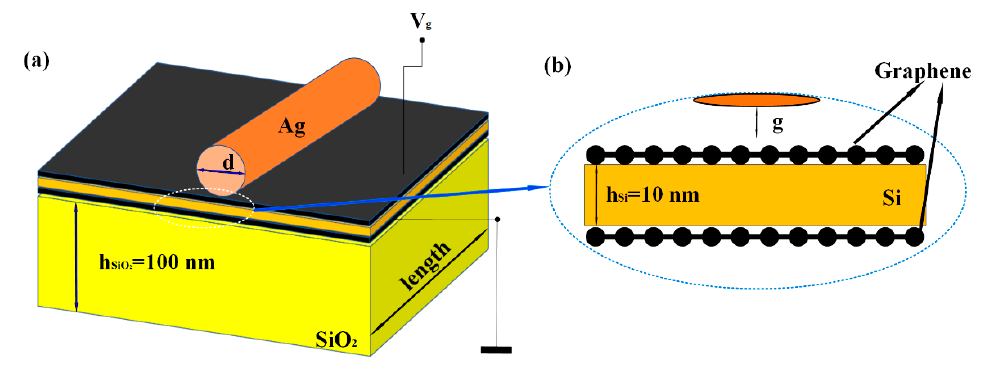
Figure 1. The stereograph and sectional view of graphene electro-optical switch modulator based on silver nanowire: ( a ) 3D layout structure ( b ) cross-sectional silver nanowire: ( a ) 3D layout structure ( b ) cross-sectional structure.